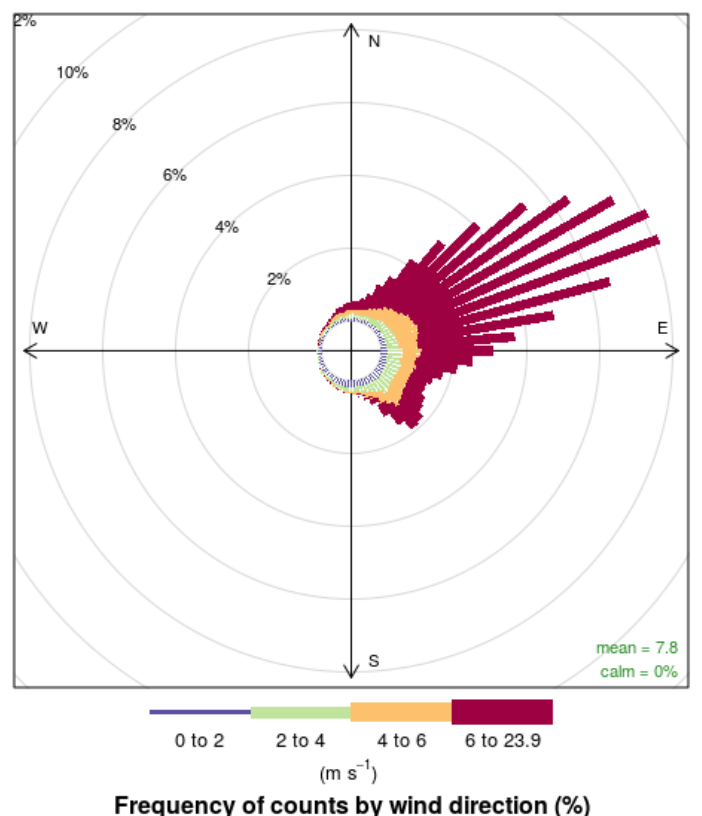
Figure 3. Wind rose for downslope wind outbreak on 17 November 2017. The main wind direction was NE, with the peak wind speeds exceeding